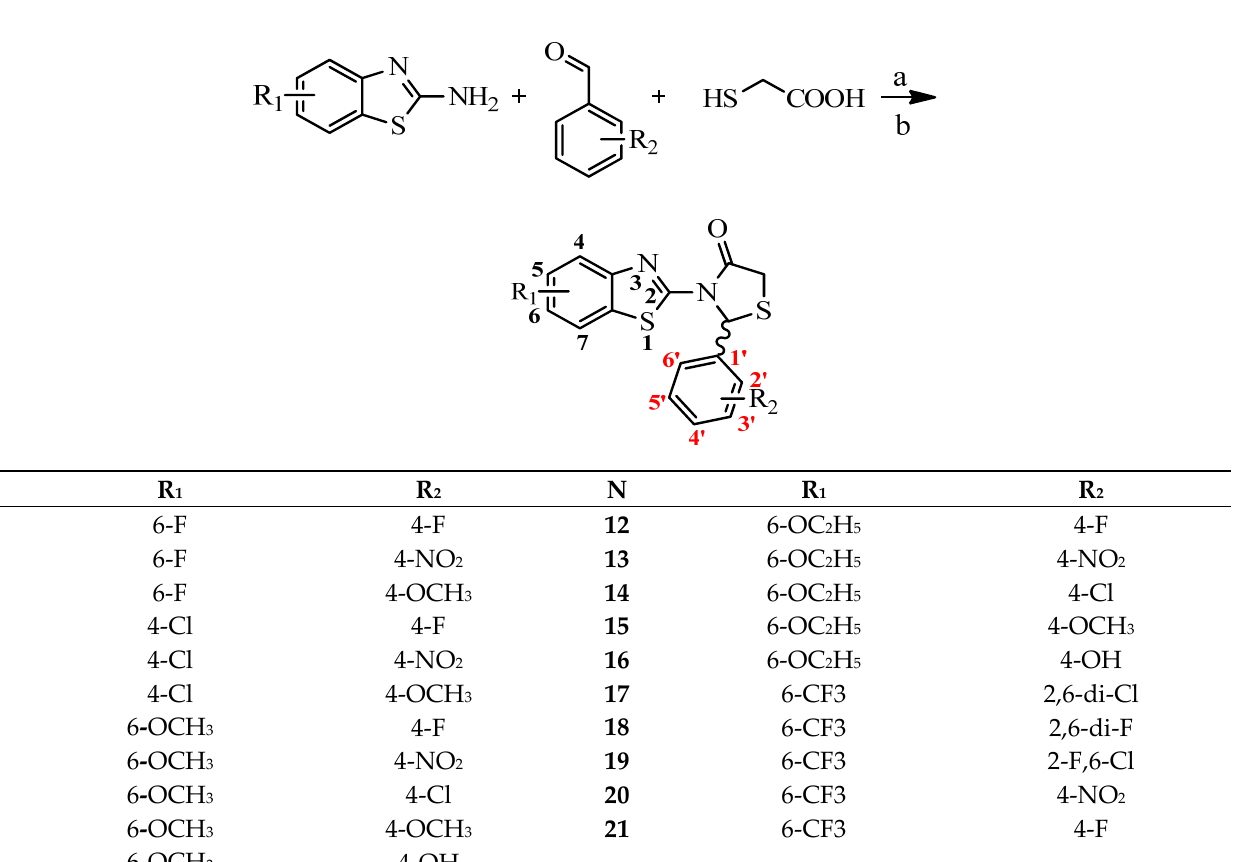
Figure 2. Approved drugs with thiazolidinone scaffold.